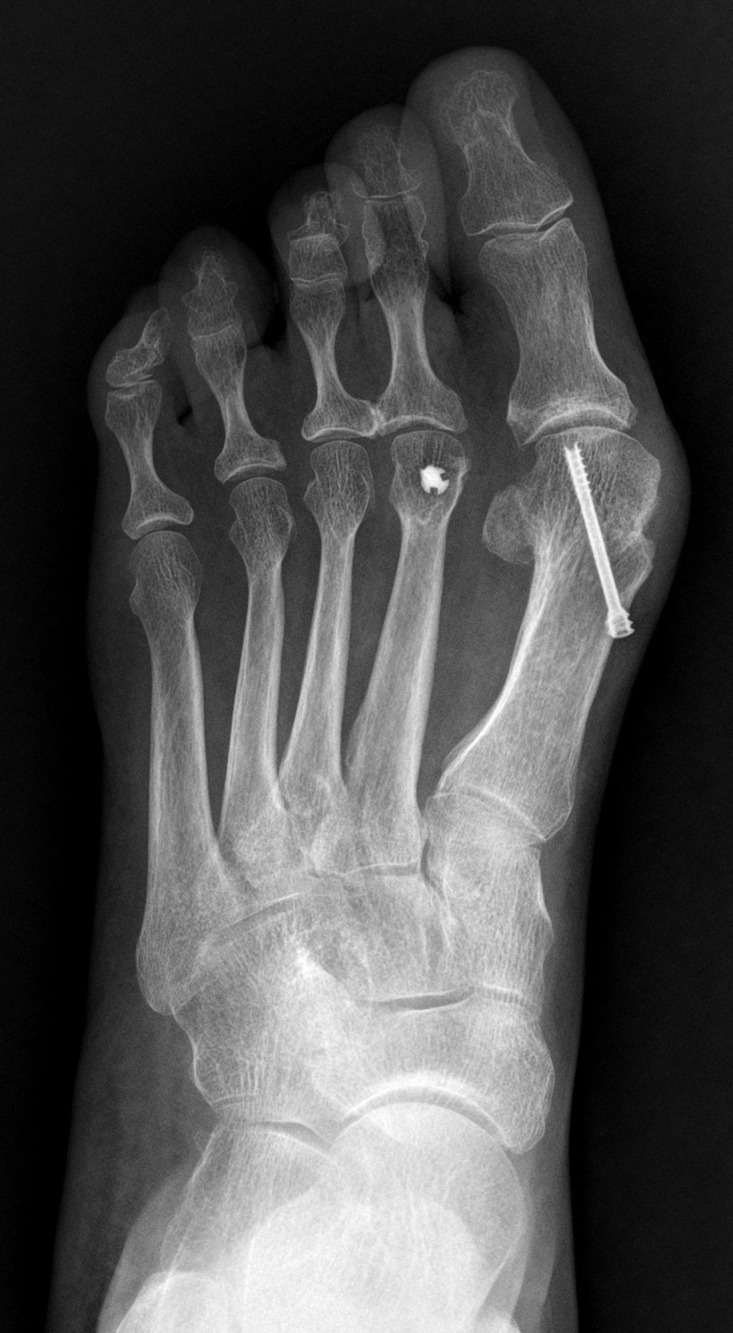
Twenty months after operation.Hallux valgus recurrence was noticed.